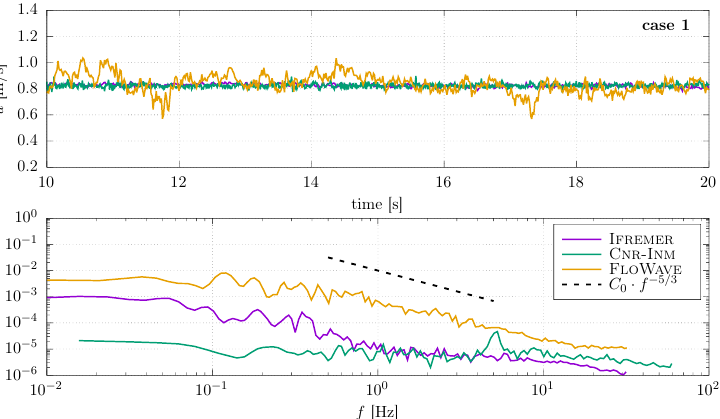
Figure 5. Time histories (top) of the ADV streamwise velocity u measured at the top-dead centre of the rotor for case 1 and their corresponding PSD (bottom) at I FREMER , F LO W AVE and C NR -I NM . The PSD panel also includes Kolmogorov’s 5/3 power −